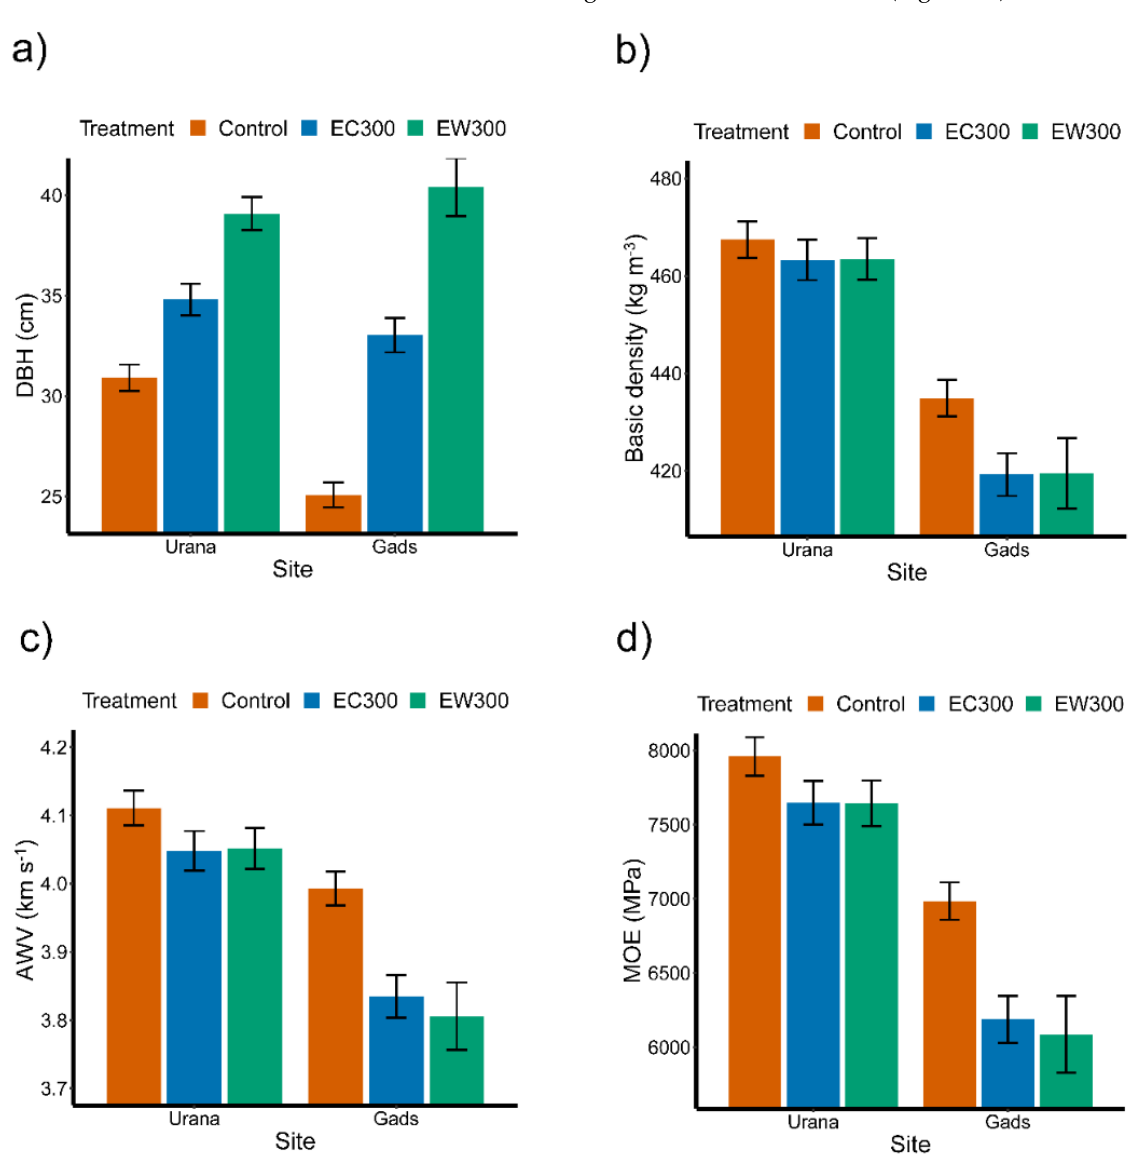
Figure 3. Least-square means and their standard errors estimated from the fitted second model showing the effect of commercial (EC300, blue bar) and non-commercial (EW300, green bar) thinning relative to the unthinned control (orange bar) on tree size (( a )—DBH) and wood properties (( b )—Basic density; ( c )—Acoustic Wave Velocity; ( d )—Modulus of Elasticity) at Urana and Gads.